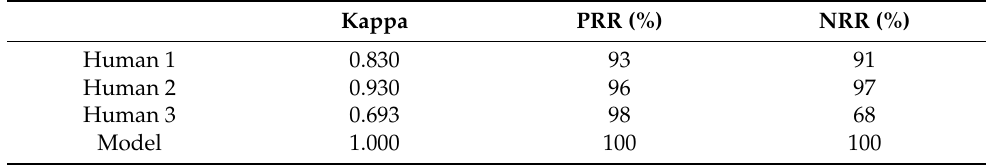
Table 2. Intrarater reliability represented by kappa coefficients, PRR and NRR.